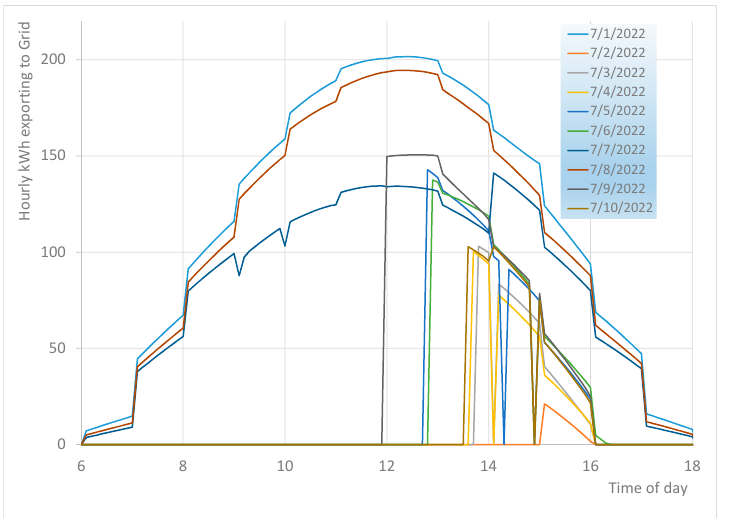
Figure 15. Hourly distribution of electricity exported to the grid for the fi rst 10 days of July.